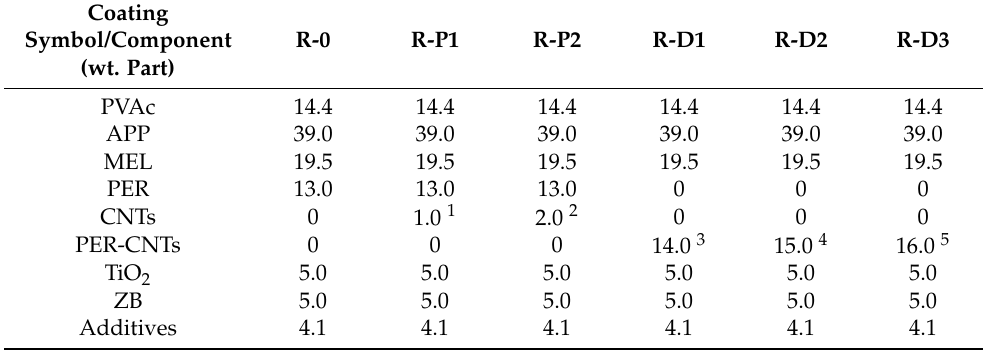
Table 1. Intumescent coating